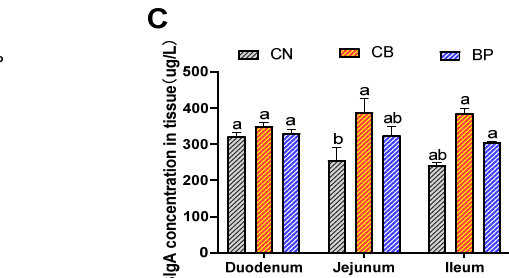
Figure 5. Effects of CN, CB, and BP on IgG and IgM levels and secretory immunoglobulin A in rabbits. ( A , B ) Serum concentrations of IgG and IgM at the middle phase (M = 21 days) and later phase (L = 42 days). IgG, immunoglobulin G; IgM, immunoglobulin M; ( C ) secretory immunoglobulin A concentration in tissue. CN, rabbits were fed a basal diet; CB, rabbits were fed a basal diet supplemented with Clostridium butyricum ; BP, rabbits were fed a basal diet supplemented with a bacteriophage cocktail (values are expressed as the mean ± SE, n = 8; a,b Mean values within a row with unlike superscript letters were significantly different ( p < 0.05).